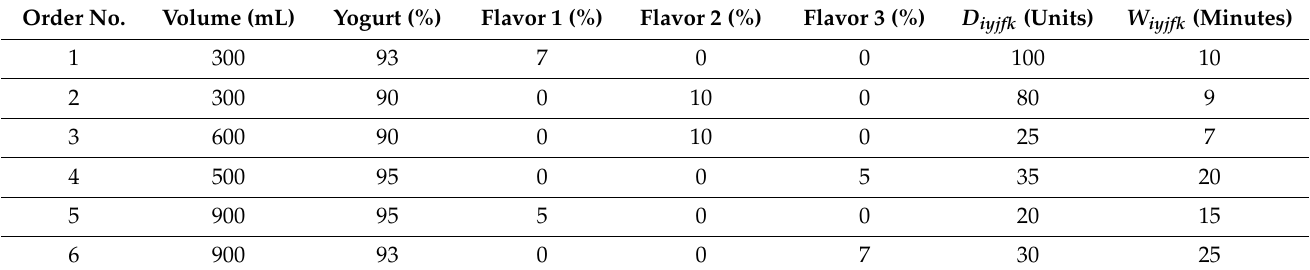
Table 3. Orders from customers.